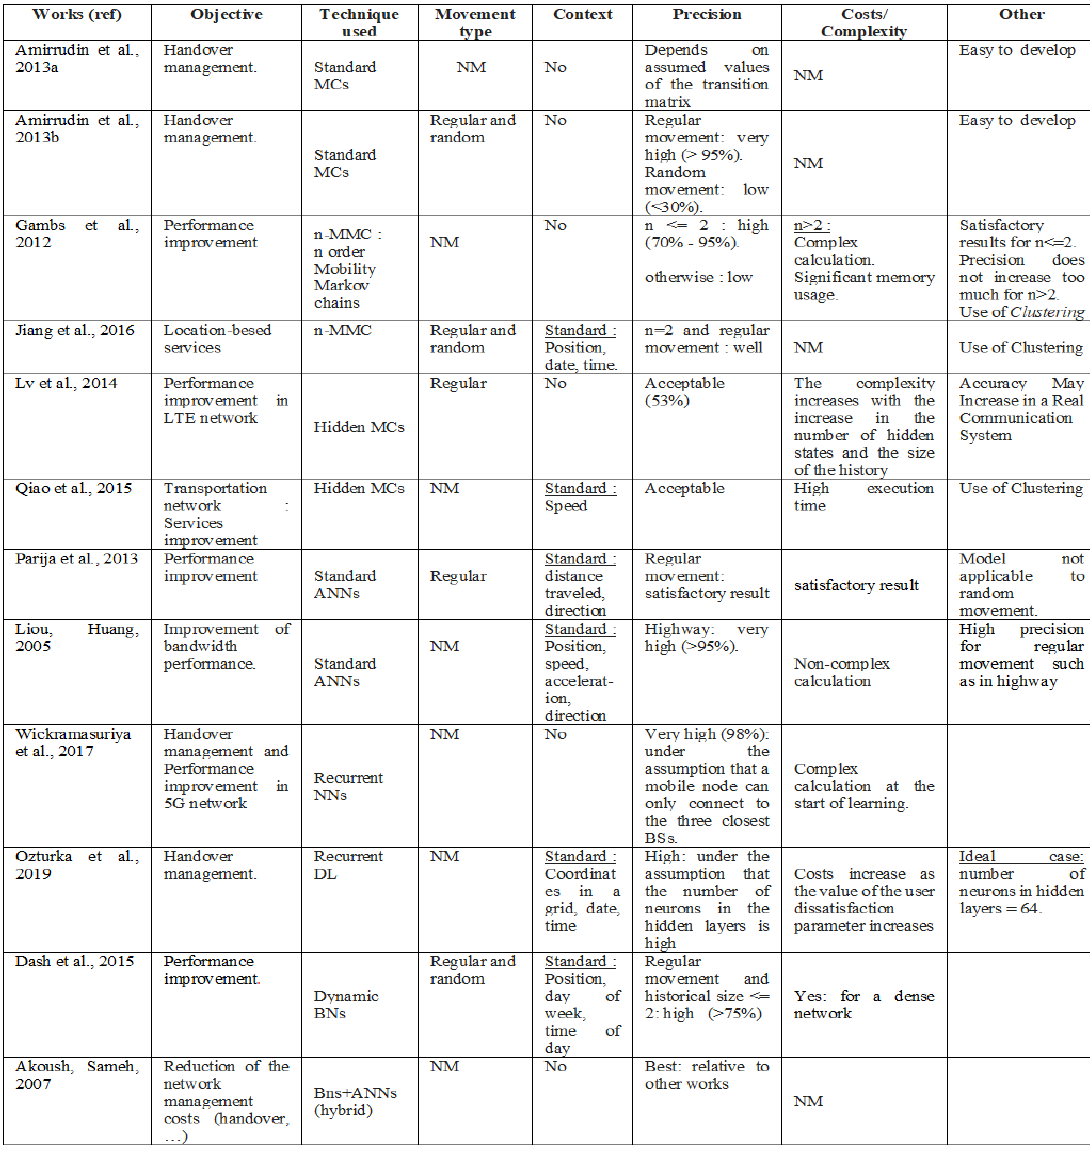
Table 2 . Summary on mobility prediction